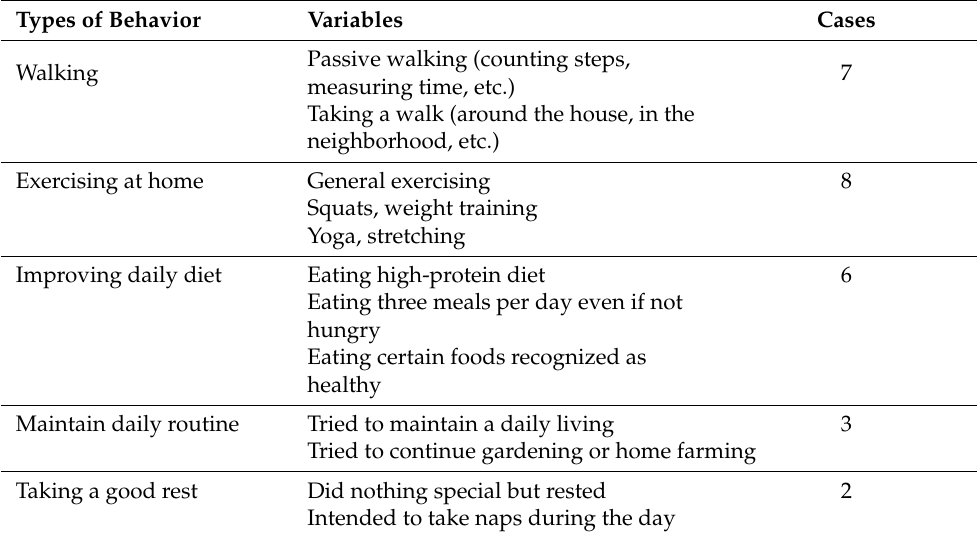
Table 2. Types of behaviors engaged in when declining physical fitness was perceived during the COVID-19